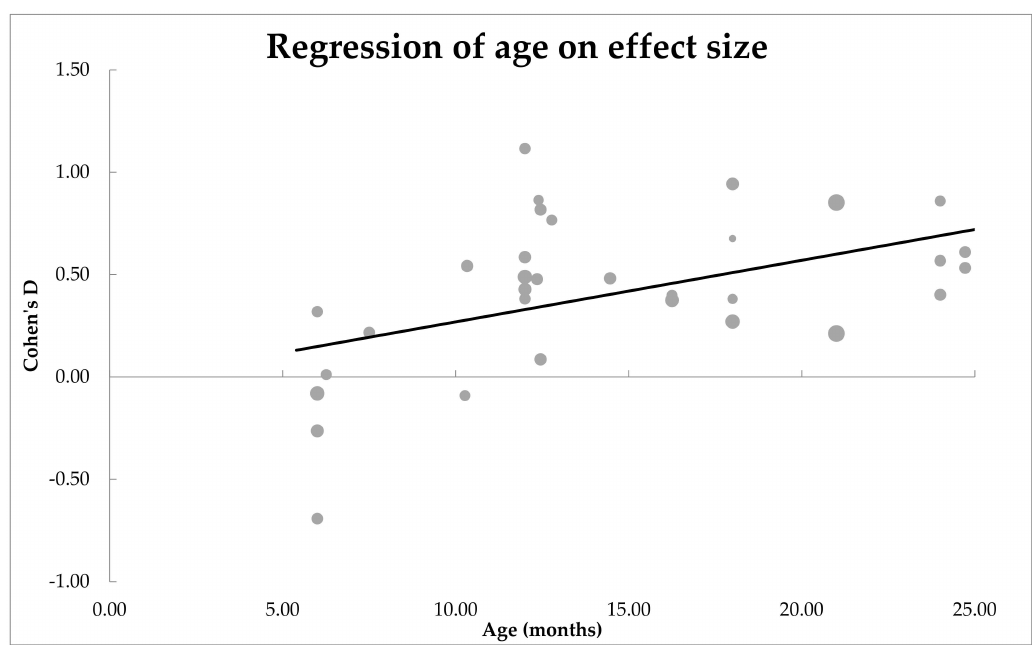
Figure 3. Scatterplot of how age moderated the mean difference between EL and TL infants’ receptive vocabulary. A significant effect of moderator was